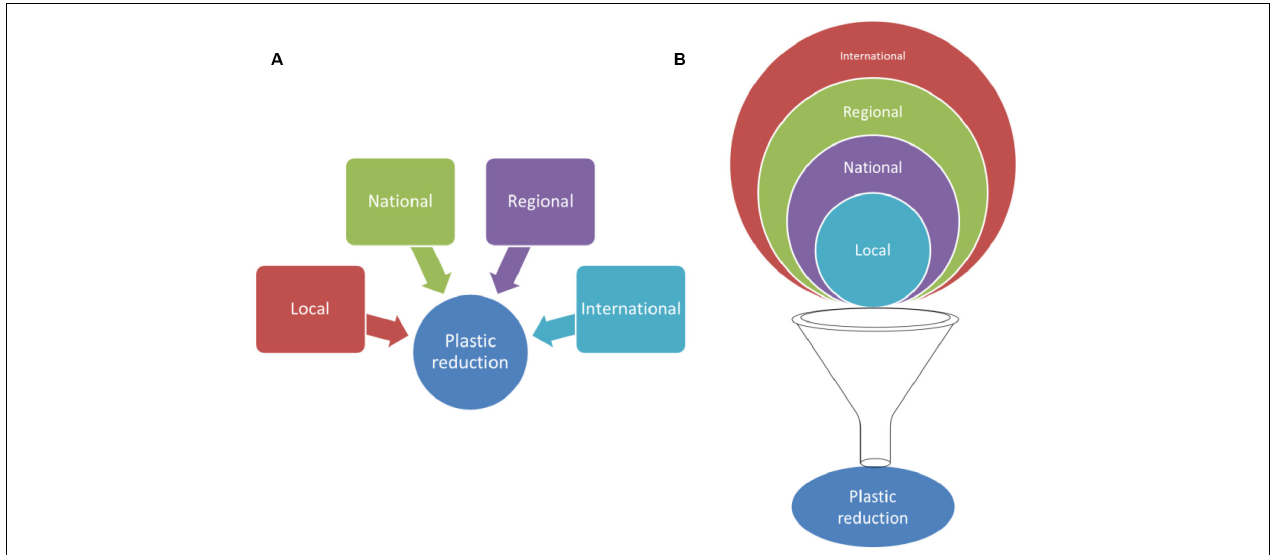
FIGURE 4 | In (A) , how, currently, the different levels of regulatory instruments are applied. In (B) , how, ideally, such instruments should interact and correlate, effectively constituting the framework of a global approach toward the reduction of plastic waste in the